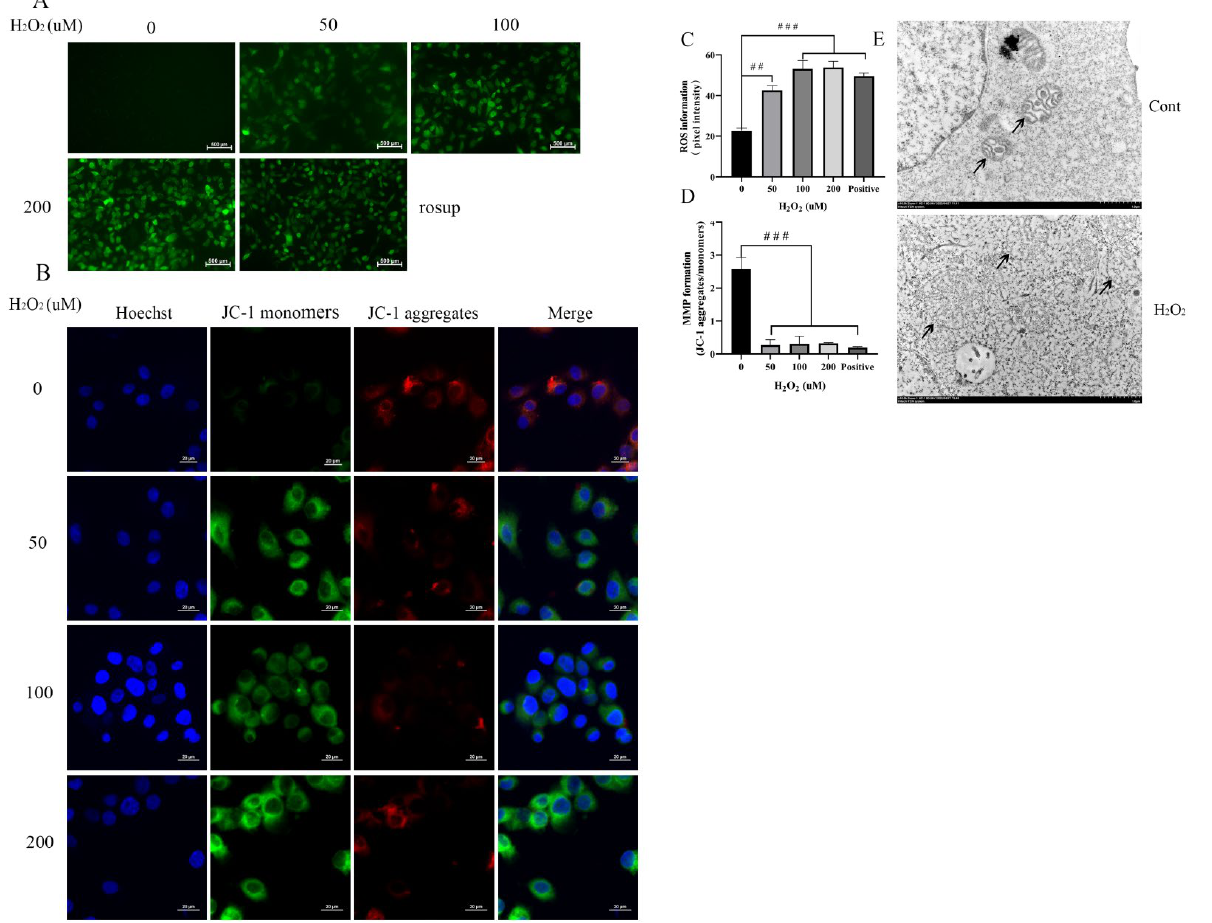
Figure 4. H 2 O 2 -induced intracellular ROS increase and MMP decrease in BEECs. ( A ) BEECs were exposed to the indicated concentrations of H 2 O 2 for five hours. Rosup was a positive control. ROS levels were detected by DCFH-DA fluorescence (green). ( B ) MMP (mitochondrial membrane poten- tial) was detected with the JC-1 kit. Cellular mitochondria with normal MMP emitted red fluores- cence (J-aggregate), while those with abnormal MMP showed green fluorescence (J-monomer). ( C ) Quantification of intracellular ROS levels relative to the untreated group. ( D ) Quantitative analysis of the MMP. The MMP was calculated using Image-J as red/green fluorescence. ( E ) After being ex- posed to the indicated concentrations of H 2 O 2 for five hours, the mitochondria of BEECs were ana- lyzed by transmission electron microscopy. The typical mitochondrial structures are clearly visual- ized: black arrowheads depict the mitochondria. The data are representative of three independent experiments. The optical density was calculated for each sample with ImageJ 1.47v software. The experiment was repeated in triplicate. One-way ANOVA analysis was used compared to the control group. ## p < 0.01, ### p < 0.00 .